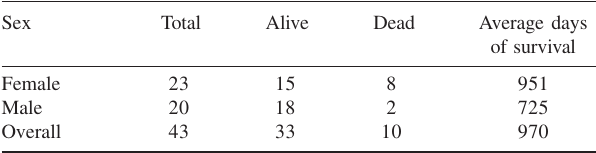
Table 1- Days of survival by sex